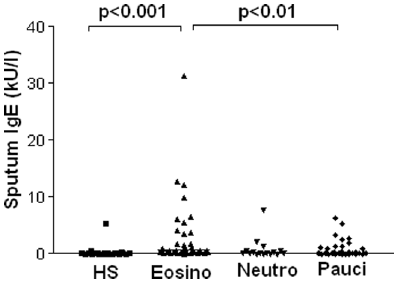
Figure 1. Sputum total IgE in asthmatics according to sputum cellular profile.